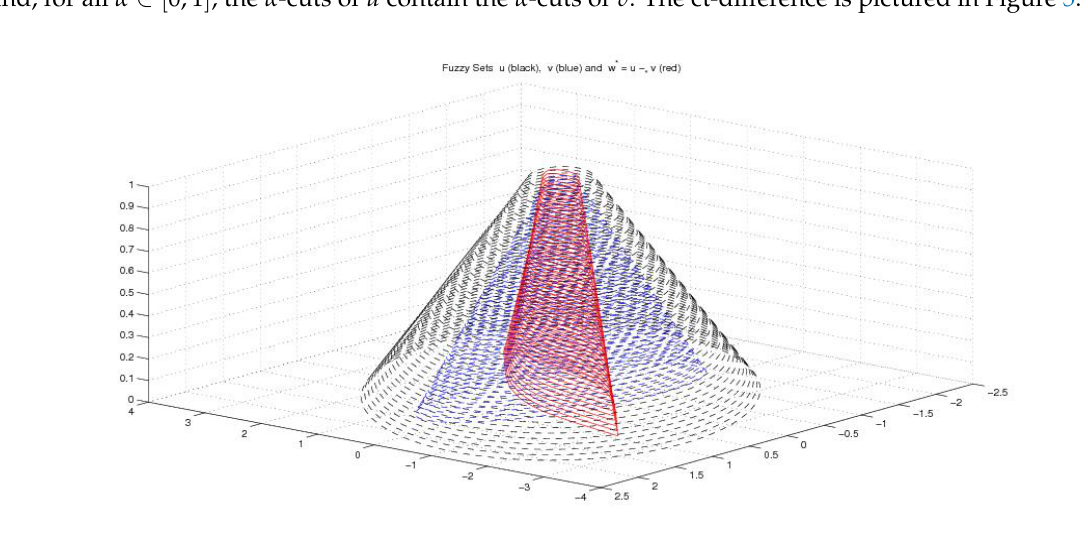
Figure 5. Fuzzy Example 1. Fuzzy sets u (black), v (blue) and fuzzy ct-difference w ∗ = u (cid:9) ct v